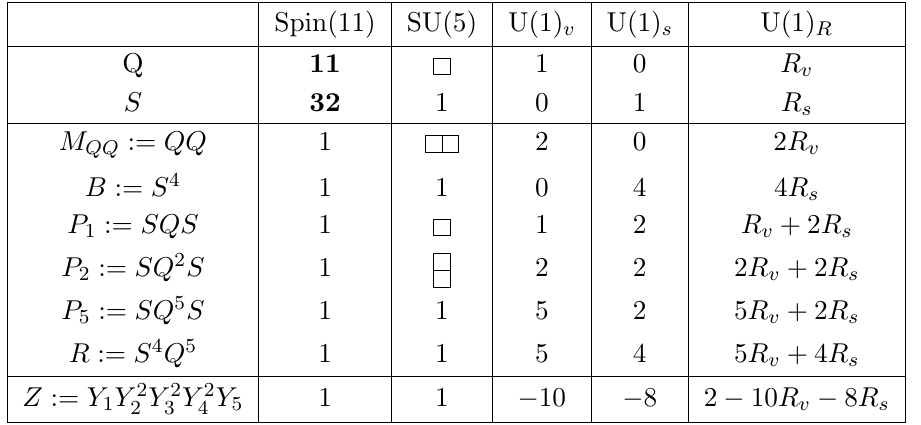
Table 18 . 3d N = 2 Spin(11) theory with ( N v ; N s ) = (5 ; 1).